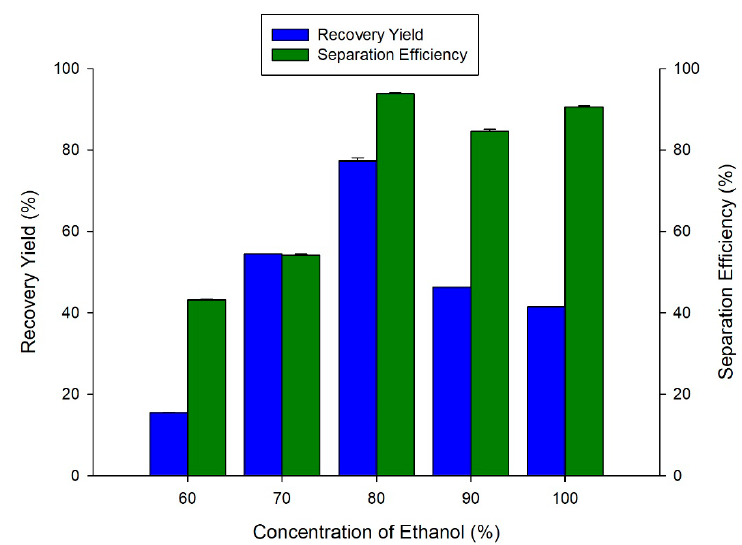
Figure 5. Figure showing effect of various concentrations of ethanol on protein recovery yield and separation efficiency using LBF system.